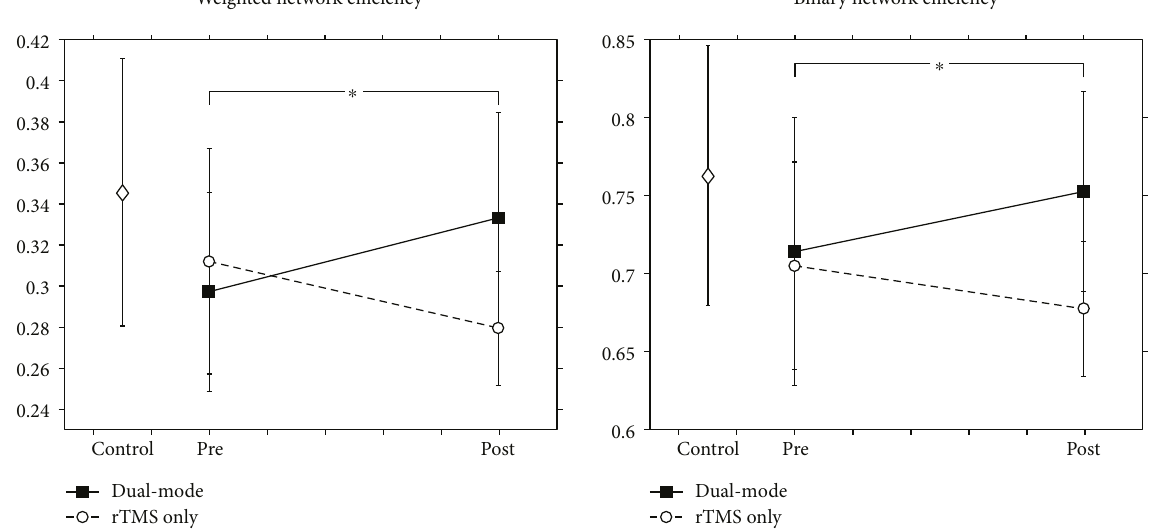
Figure 2: Changes in weighted and binary network e ffi ciencies caused by stimulation. Both weighted and binary network e ffi ciencies were signi fi cantly increased in the dual-mode stimulation group compared to the rTMS-only group poststimulation ( ∗ p < 0 05